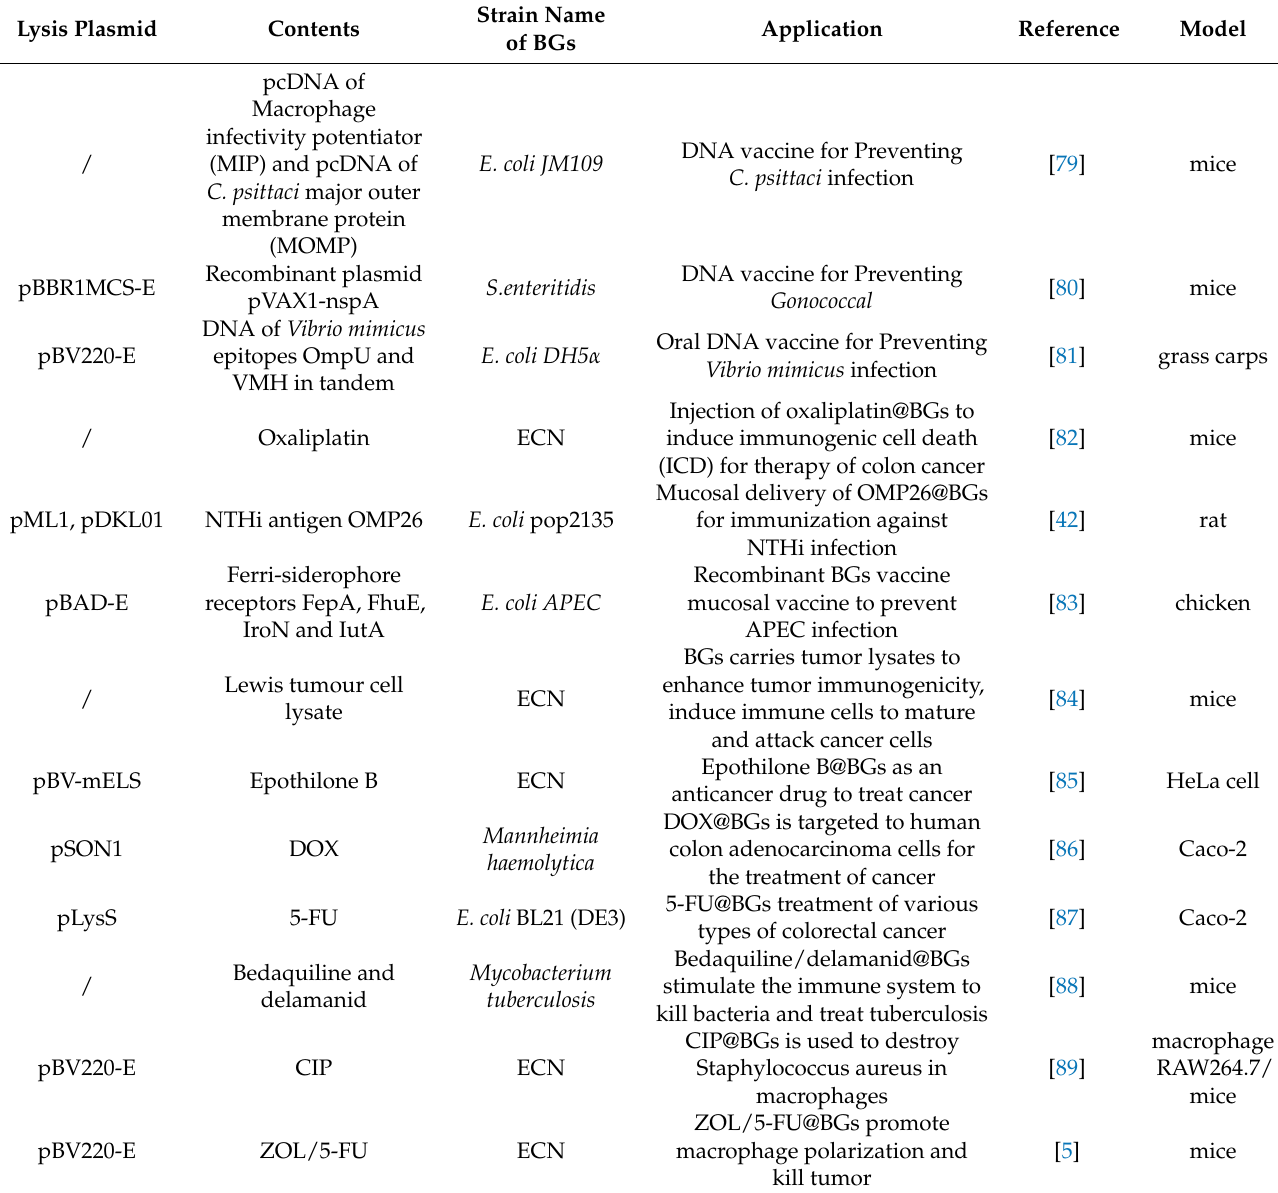
Table 1. Application strategies of BGs-based delivery